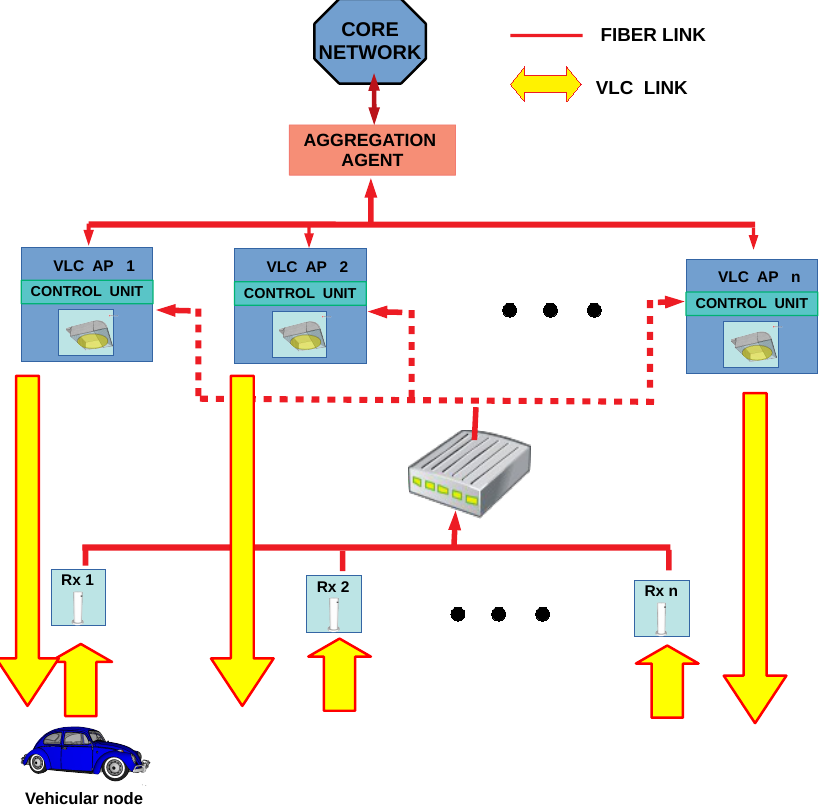
Figure 5. 2.5 Layer topology